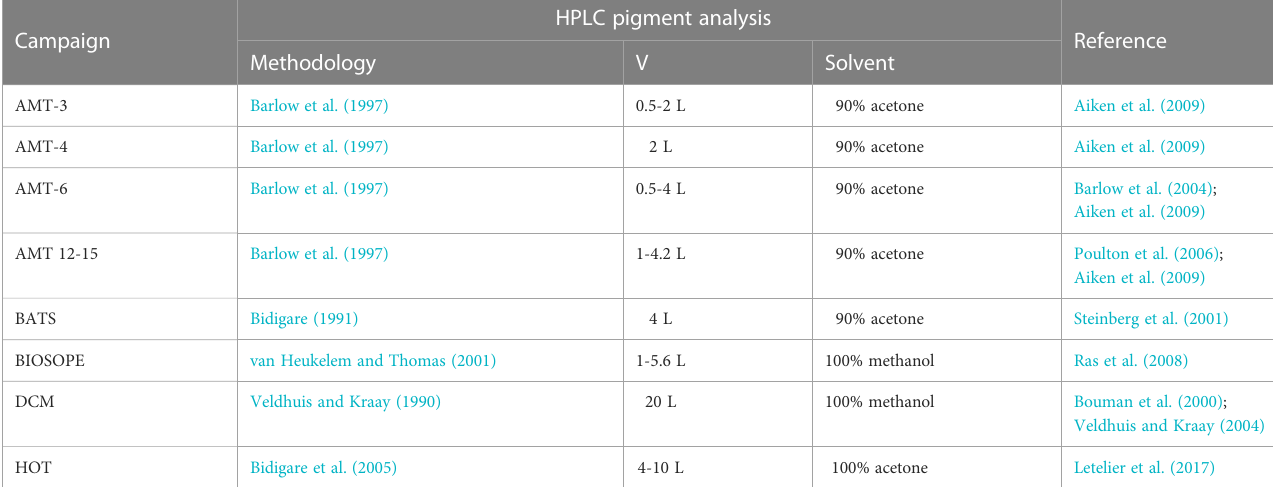
HPLC pigment analysis